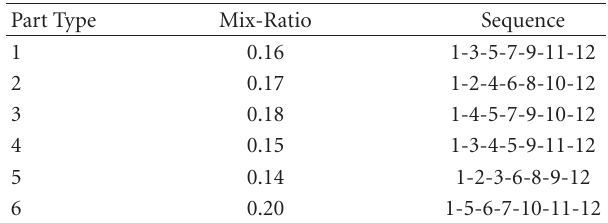
Table 3: The mix-ratio and process sequence of each part.